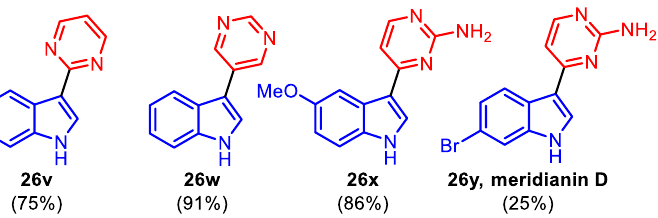
Figure 16. Indole alkaloids 26 synthesized through one-pot MBSC protocol of the Müller group [48,49].